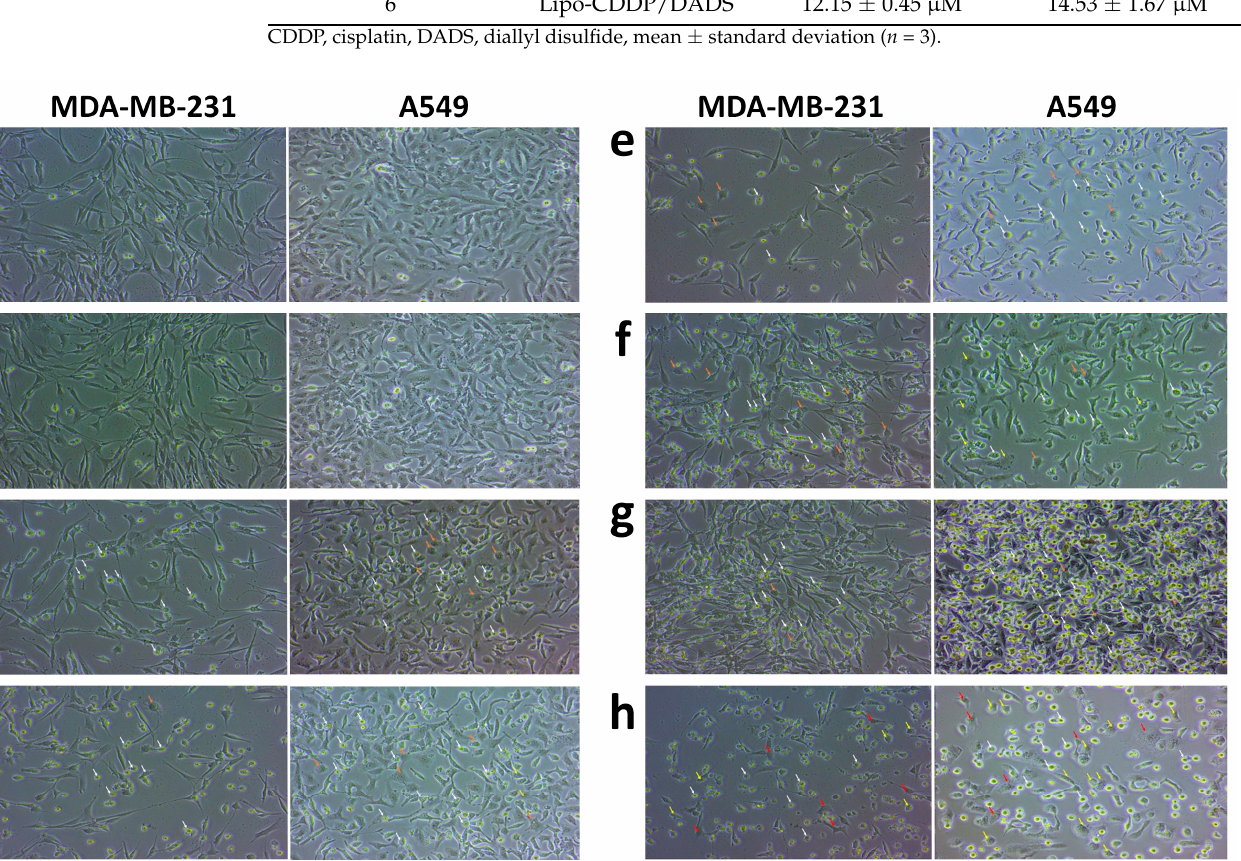
Figure 7. Morphological analysis by control, free drugs, and drug(s)-loaded nanoliposomes on MDA-MB-231 and A549 cell lines. ( a ) Control, ( b ) free liposomes, ( c ) free CDDP, ( d ) free DADS, ( e ) free CDDP/DADS, ( f ) Lipo-CDDP, ( g ) Lipo-DADS, and ( h ) Lipo-CDDP/DADS. White arrows indicate apoptotic cells and orange arrows indicate the bubbling of cells. The yellow arrow indicates chromatin condensation/blebs, and the red arrow indicates spikes in apoptotic undergoing cells.